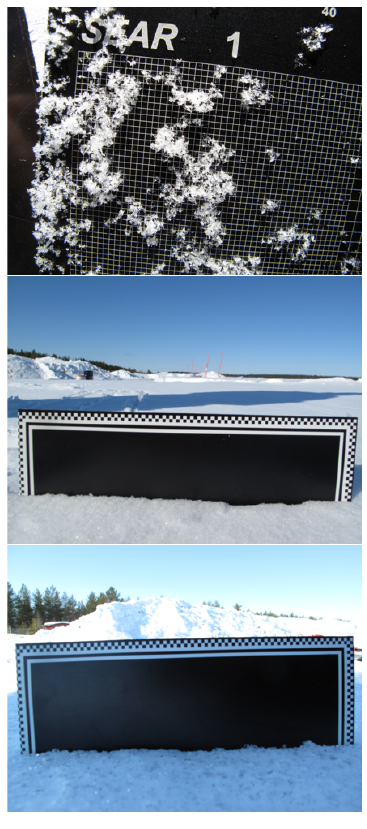
Figure 5. More snow profiles taken on the 4 April of unprocessed snow near the FIGIFIGO spot, plus one profile from the sample sooted on the 3 April, and measured on the 4 April. Table 4. Snow depth profile measured from a snow pit on 5 April 2013. Figure 6. More snow profiles taken on the 5 April of unprocessed